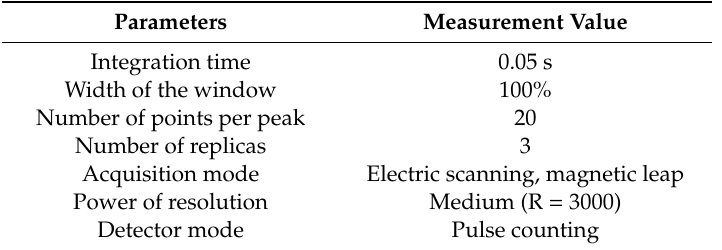
Table 5. Measurement parameters used in the double-focus ICP-MS.